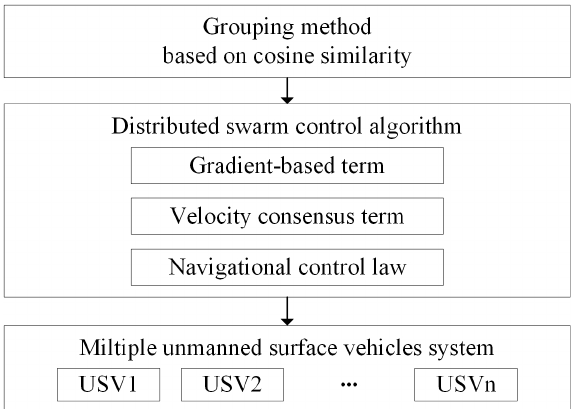
Figure 1. The structure of the proposed grouping method and distributed swarm control algorithm for multiple USVs